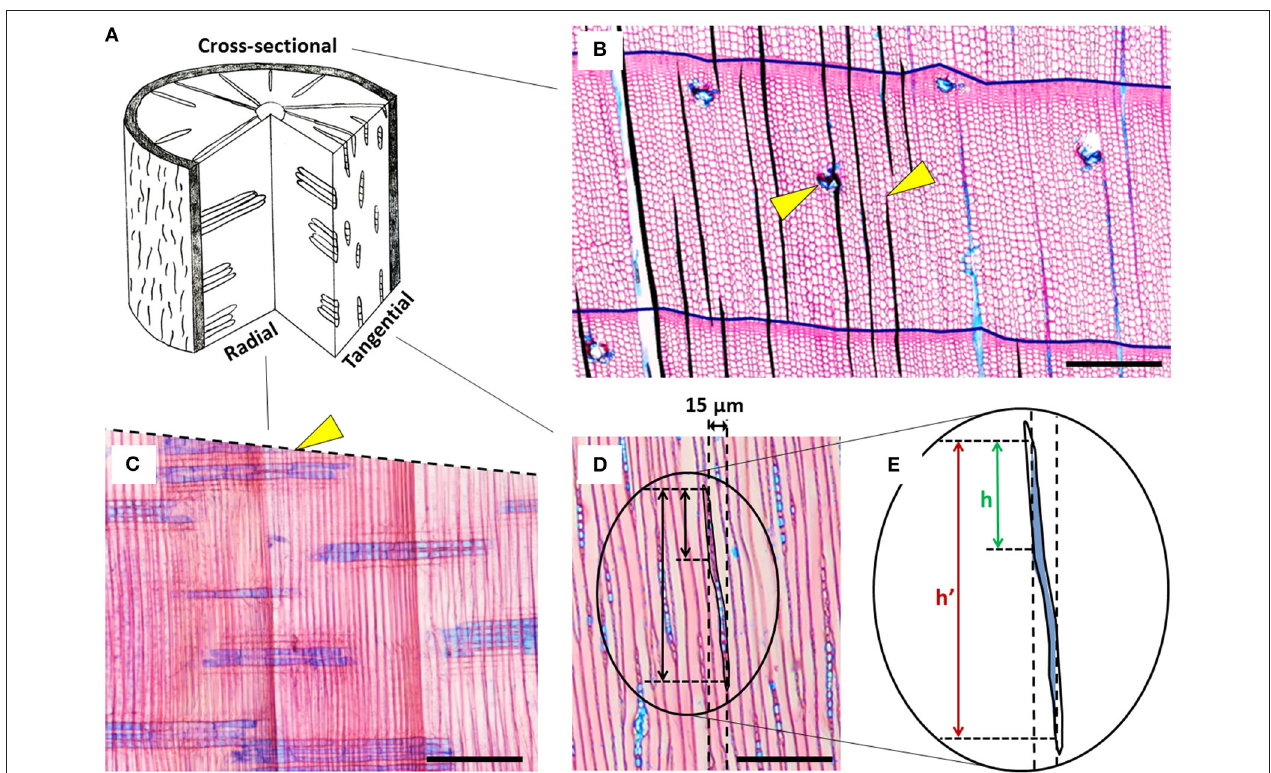
FIGURE 1 | Overview of the different cutting planes and exemplary anatomical cut-out images of Pinus sylvestris with rays stained in blue. (A) Scheme of the different cutting planes in a stem disc showing xylem rays in a 3D wood context. (B) Cross-section showing some exemplary rays (area filled black) and tree-ring borders (black lines); the right arrow indicates a disappearing ray, likely due to non-perpendicular orientation of the section; the left arrow indicates a ray with an incorporated resin duct that was excluded from analysis. (C) Radial section; the dashed line indicates the non-perpendicular orientation of the cross-section, the arrow points at an example of the “ending ray artifact” in the cross-sectional plane, i.e., permanently disappearing rays. The seemingly short rays show that the core was not in parallel to the radial wood structure. (D) Tangential section; the vertical dashed lines simulate a 15 µ m thick radial section and the associated “radial overestimation artifact.” (E) Zoomed-in sketch of the “radial overestimation artifact” demonstrating that the actual height h is much shorter than the measured height h’. Because of the transparency of the tissue, the perceived ray contour corresponds to the maximum ray projection through the entire thickness of the section. Horizontal black bars in all anatomical images indicate 100 µ